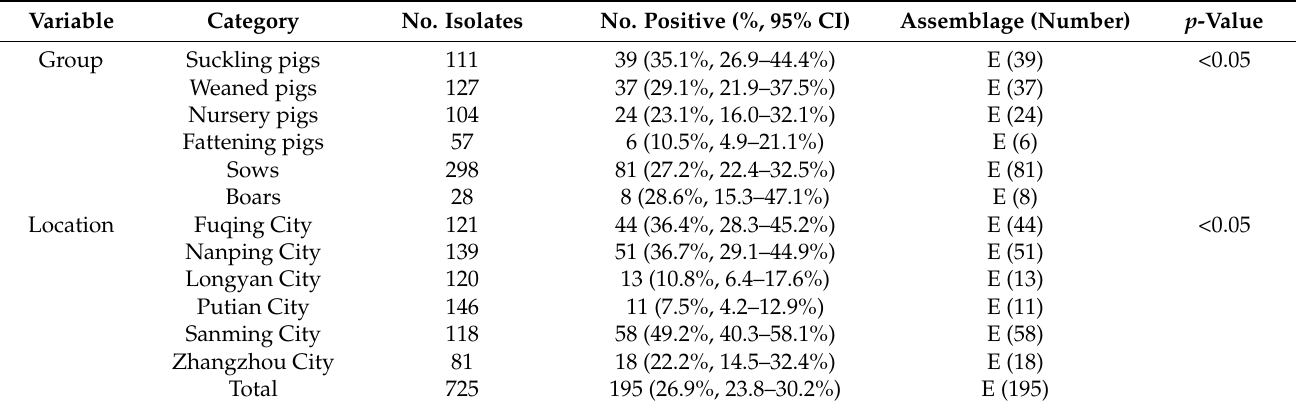
Table 1. Prevalence of G. duodenalis infection in pigs in Fujian Province.